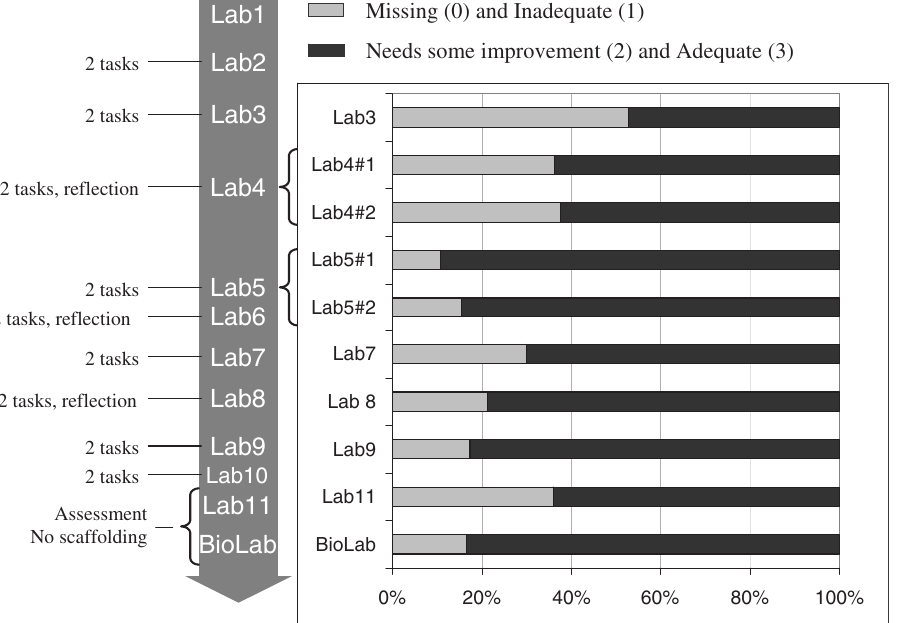
FIG. 4. Ability to identify as- sumptions. Laboratories 4 and 5